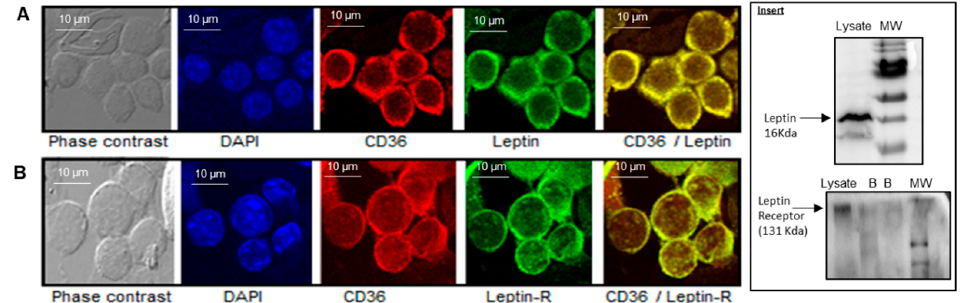
Figure 1. Co-expression of lipid sensor CD36 with leptin and leptin receptor (leptin-R) in mouse TBC. ( A , B ) show images acquired with Leica TCS-SP2 confocal laser scanning microscope. Immunoreactivity for CD36 (red) and leptin receptor (green) was observed in cultured TBC. Nuclei of cells were stained with DAPI ( A , B ). Insert shows western blot of leptin and leptin receptor. The TBC (1 × 10 6 cells per assay) were lysed and processed for western blotting as described in Materials and Methods. B (insert) = blank without protein. MW = molecular weight.